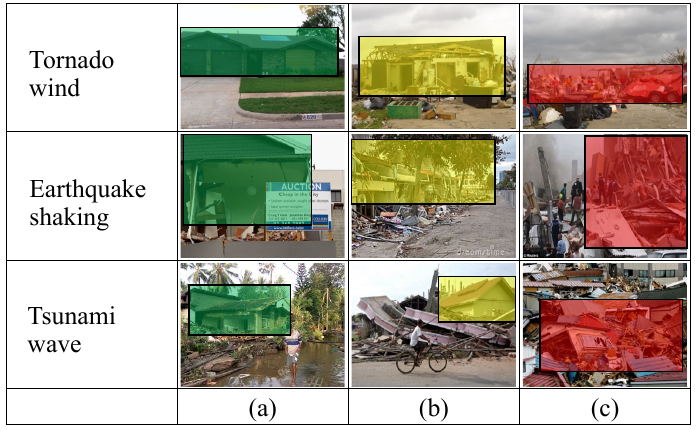
Figure 2. Sample disaster-scene images labeled with hazard-type and damage-level with bounding- box annotation: ( a ) green box means minor damage, ( b ) yellow for moderate damage, and ( c ) red for severe to collapse